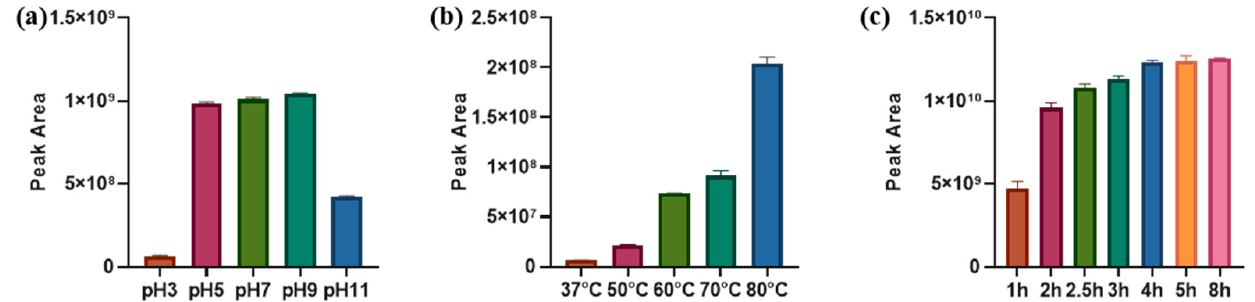
Figure 2. Effects of pH, temperature, and time effect on urea derivatization. ( a ) The conversion rate of carbamoyl-Ala under different pH conditions (3–11). ( b ) The conversion rate of carbamoyl-Ala under different temperature conditions (37 °C–80 °C). ( c ) The conversion rate of carbamoyl-Ala under different time conditions (1–8 h). Each condition was conducted for three biological replicates. HPLC method of Figure 2: mobile phase A: deionized water (0.1% formic acid); mobile phase B: acetonitrile. The gradient program was as follows: 0–5 min, 5%; 5–13 min, 5–75%; 13–15 min, 75%; 15–17 min, 75–5%, 17–22 min, 5% B. The eluent flow rate was 1 mL/min and the column was main- tained at 30 °C and 8 μ L of the sample was injected.